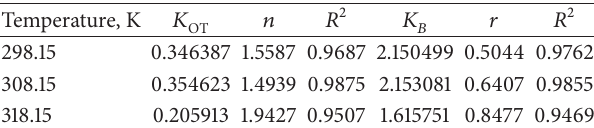
Table 6: Values of parameters of Othmer-Tobias and Bancroft equations PEG 6000 + sodium succinate + water system for various temperatures.